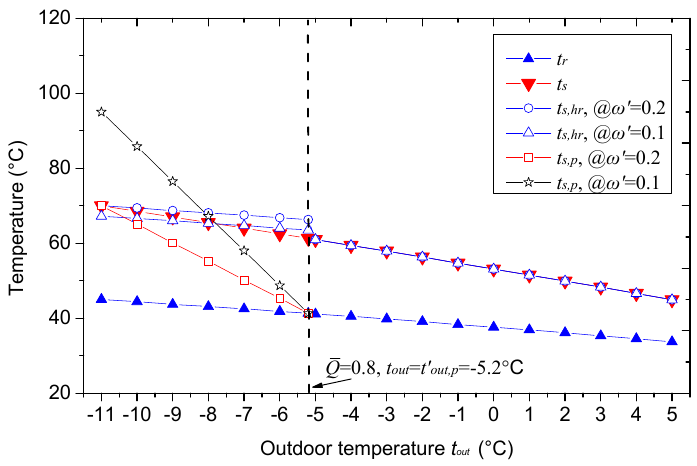
Figure 8. Variation of supply water temperature of the gas-fired boiler ( t s,p ) and heat exchanger ( t s,hr ) with outdoor temperature under working condition for parallel connection.